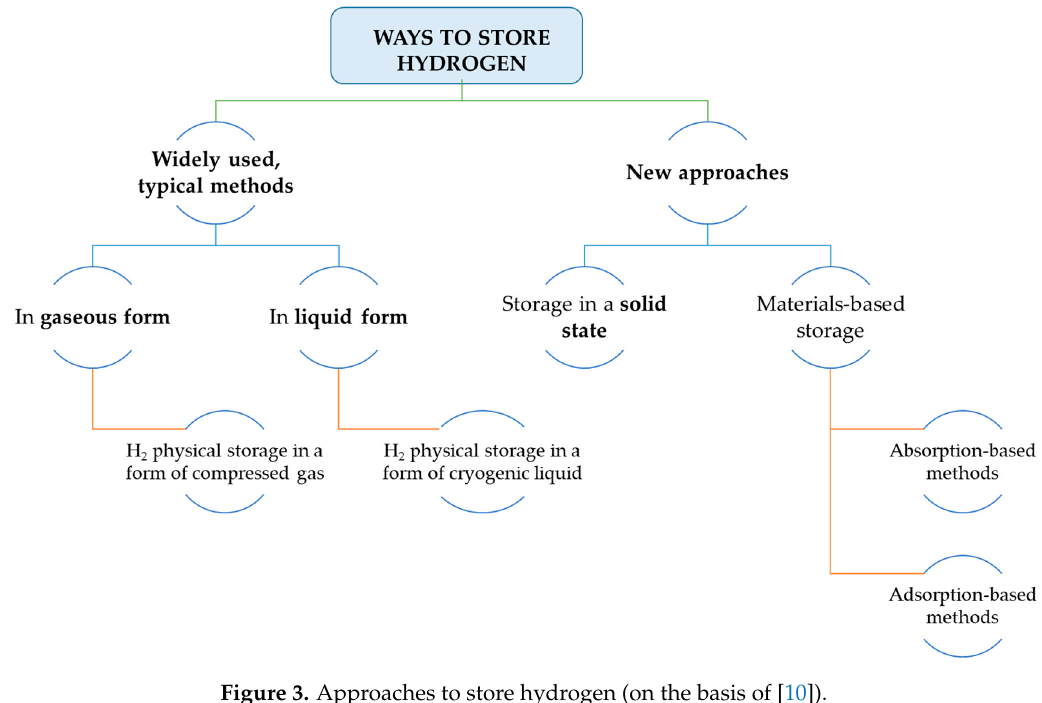
Figure 3. Approaches to store hydrogen (on the basis of [10]).